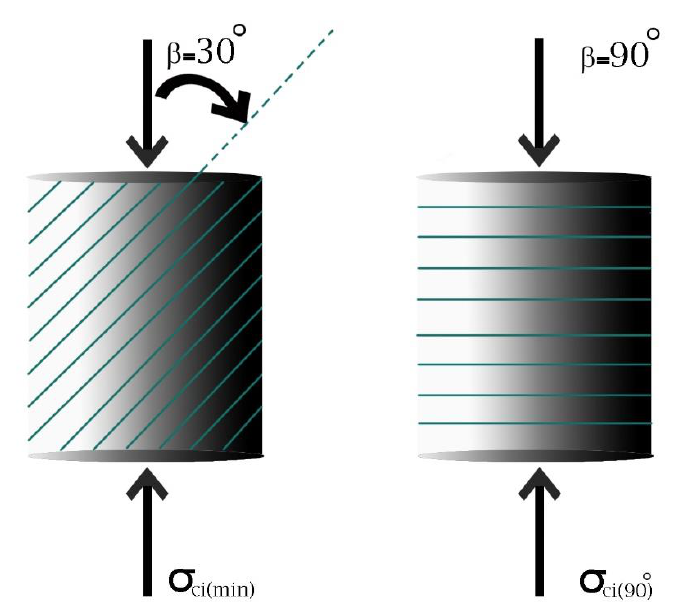
Figure 3. Minimum and maximum orientation of UCS of anisotropic intact rock.